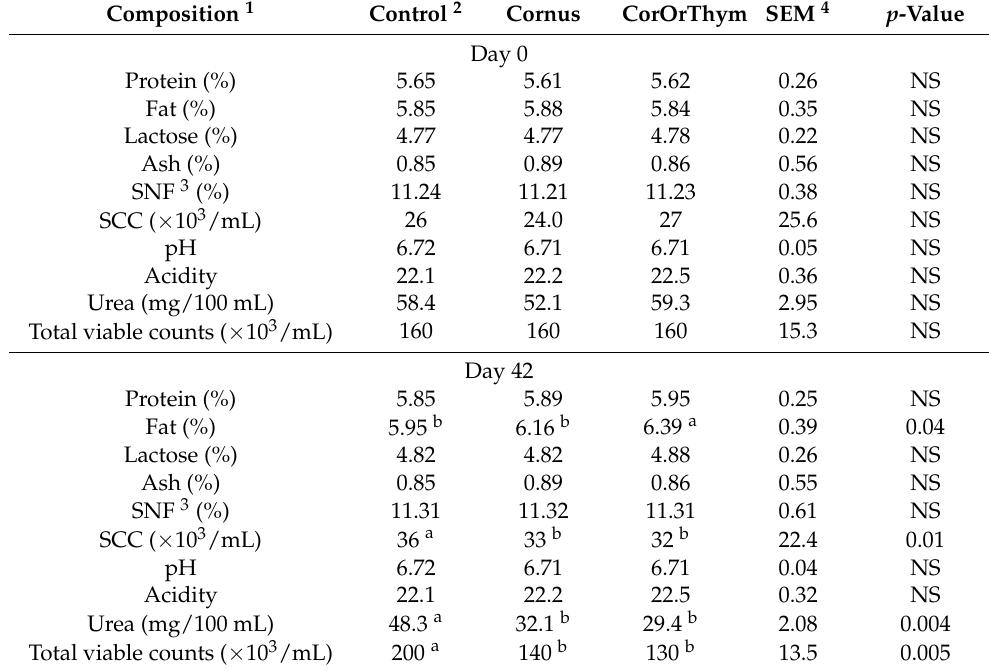
Table 6. Effects of diet supplementation with cornus extract and oregano and thyme essential oils on milk composition and somatic cell counts (SCCs) of ewes during